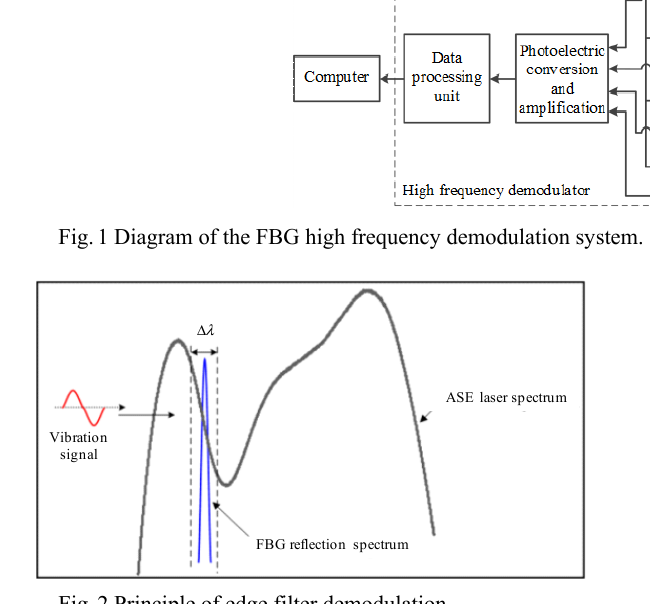
Fig. 2 Principle of edge filter